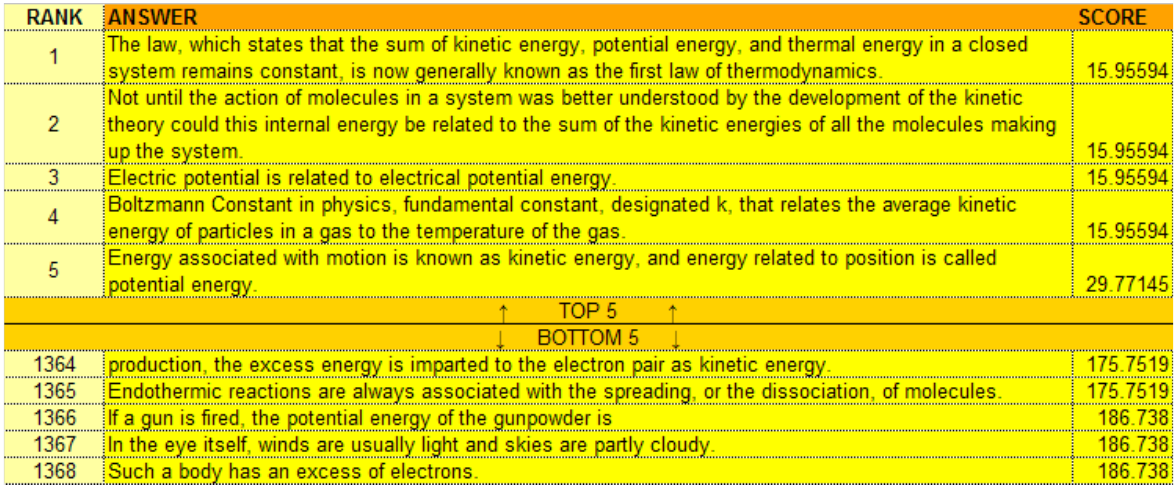
Top/Bottom Ten Answers to the Question “How are Potential and Kinetic Energy Re-